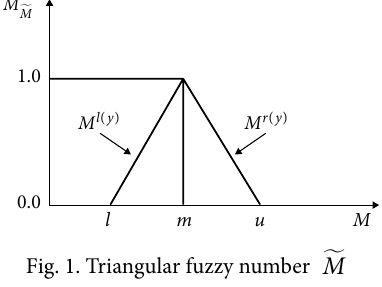
Fig. 1. Triangular fuzzy number